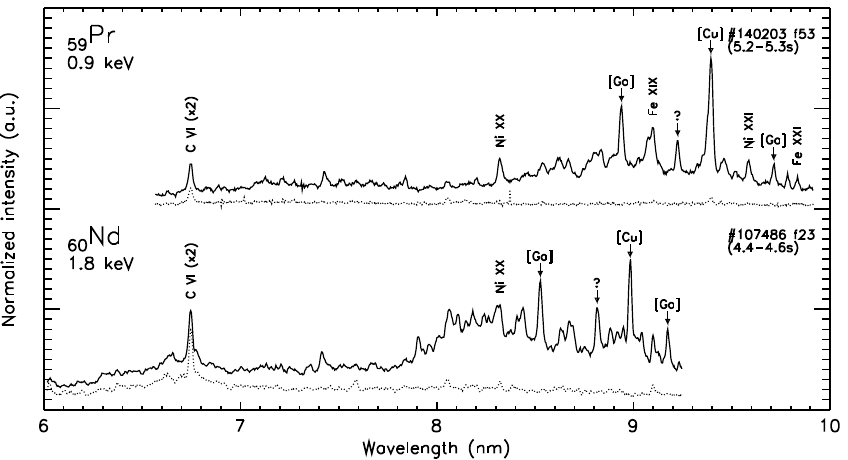
Figure 1. EUV emission spectra observed in LHD plasmas with TESPEL injections of Pr and Nd in the wavelength range of 6.0–10.0 nm. The dotted lines indicate background spectra taken before the TESPEL injection. The spectrum of each element is normalized to its maximum intensity. Isoelectric sequence of each ion is indicated by a bracket for the identified lines.